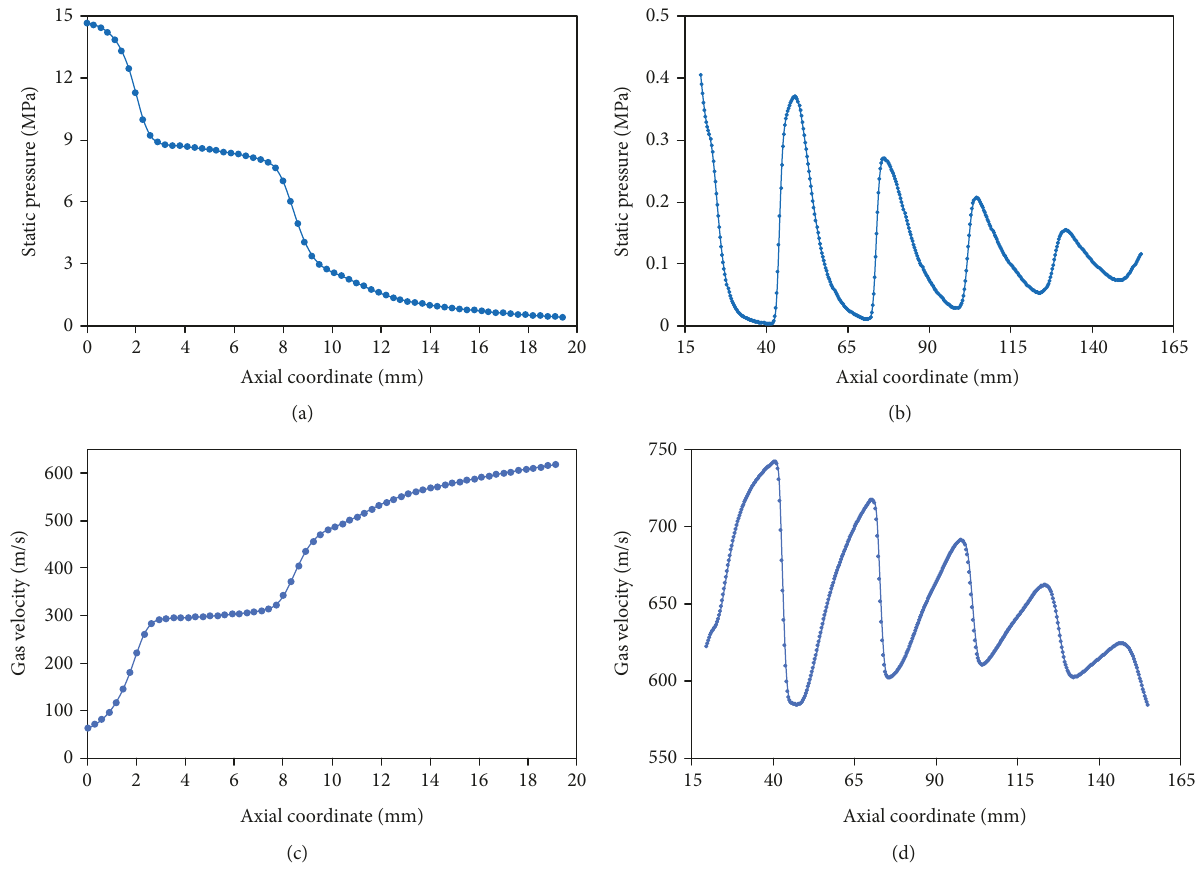
Figure 7: The static pressure and velocity of the gas